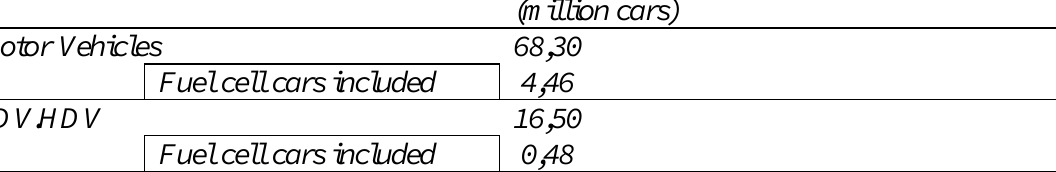
Table 7. Ownership of motor vehicles in BAU scenario (Japan on a national level,